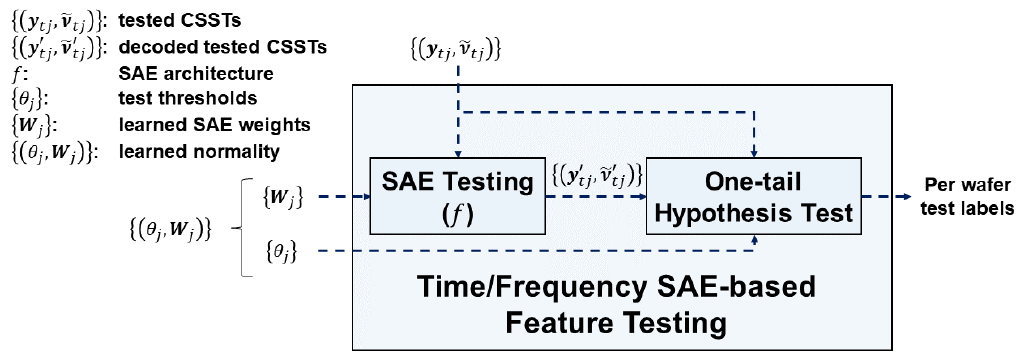
Figure 8. The time/frequency SAE-based feature testing module in STALAD. Figure 8. The time / frequency SAE-based feature testing module in